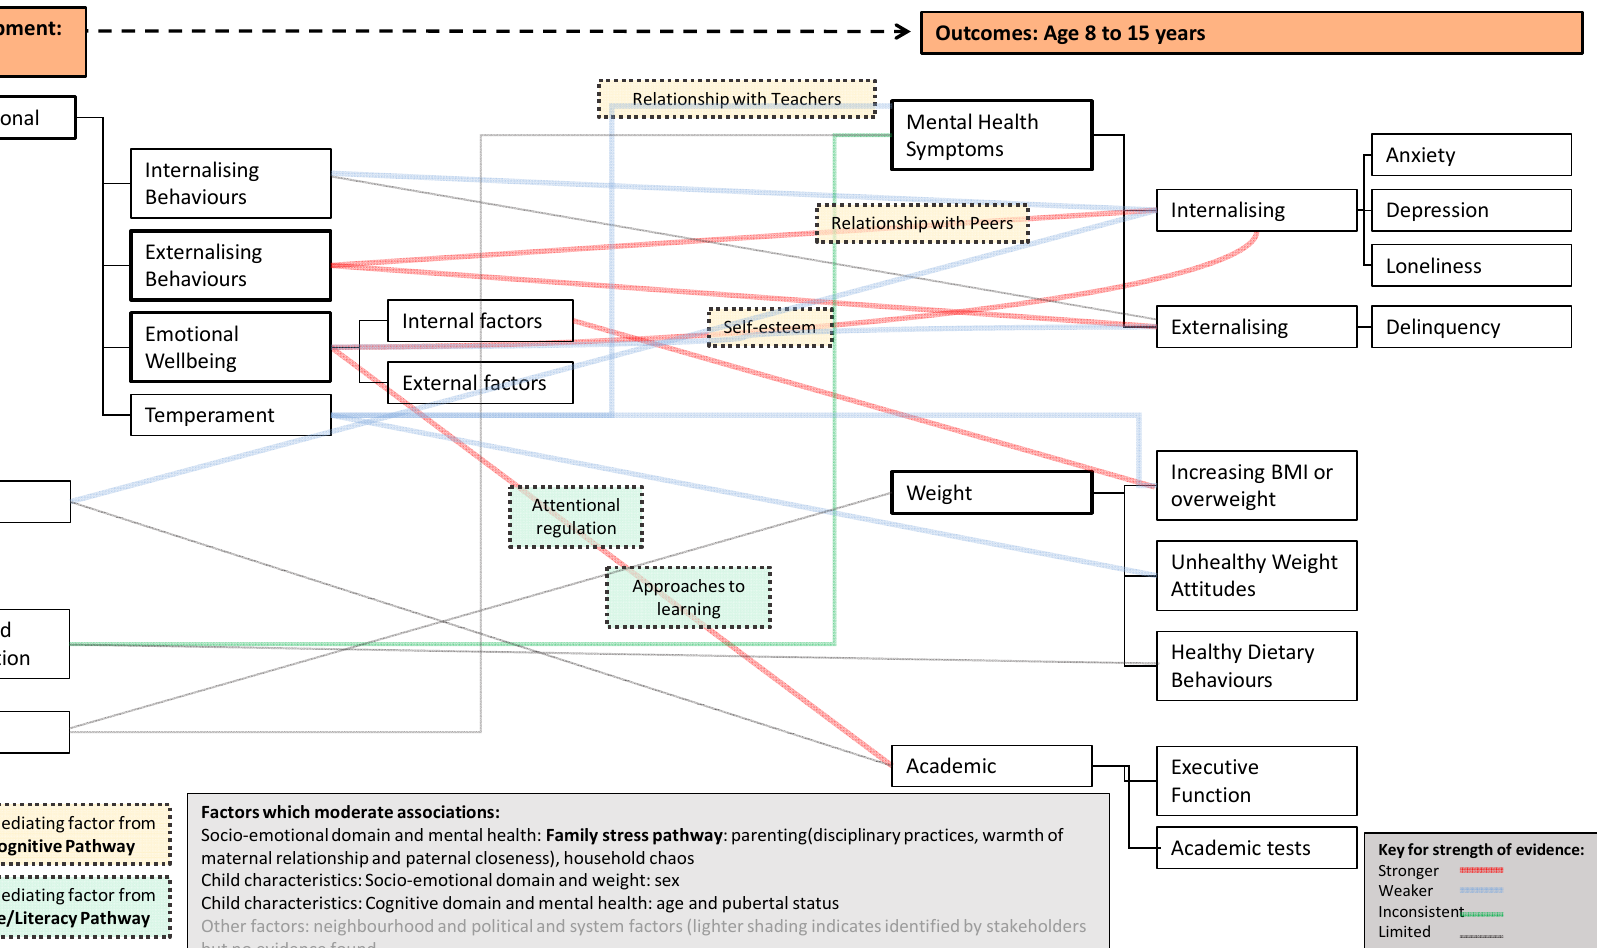
Figure 3. Diagram of the relationship between domains of child development and adolescent outcomes.